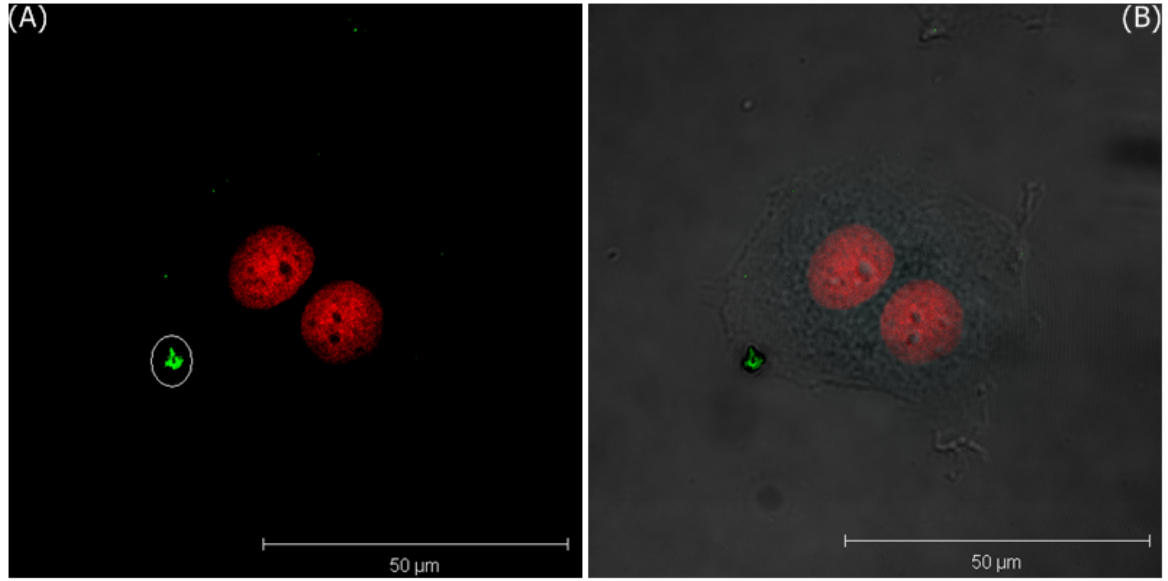
Figure 9. The 3D projection images of T-47D cells incubated with GNPs-FA in media after 5 minutes; A) LSCM image, and B) the merged image of LSCM and the phase contrast images, where the green lightspots are the expression of